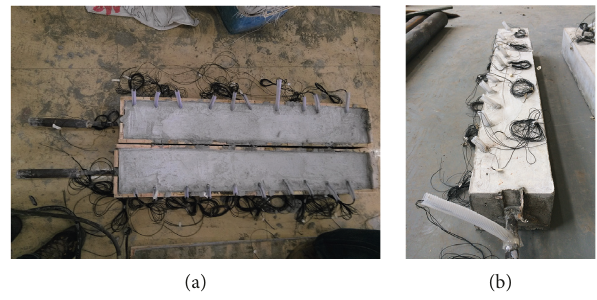
Figure 2: Specimens under unconstrained conditions.